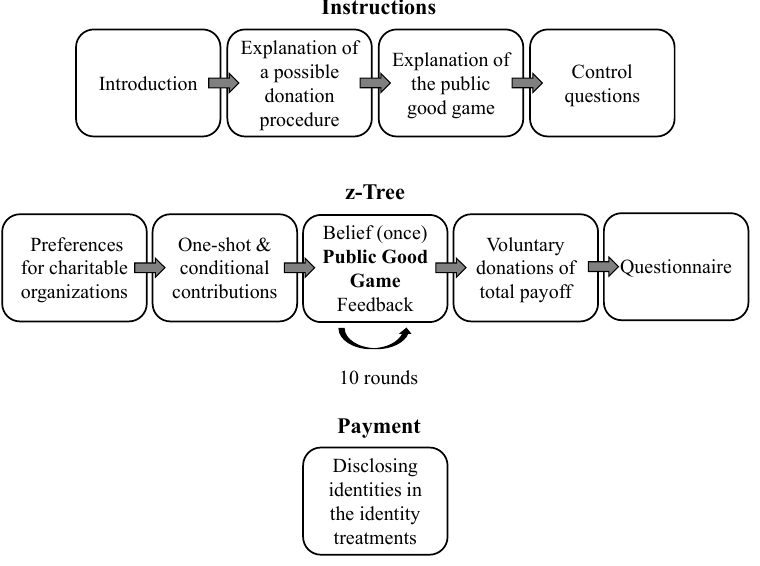
Figure 1. Procedure of the experiment.